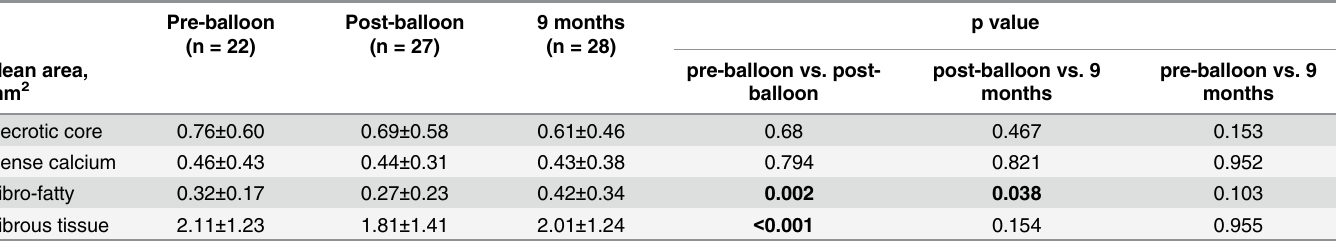
Table 5. Serial changes of IVUS-VH parameters in pre- and post-balloon and at 9 months